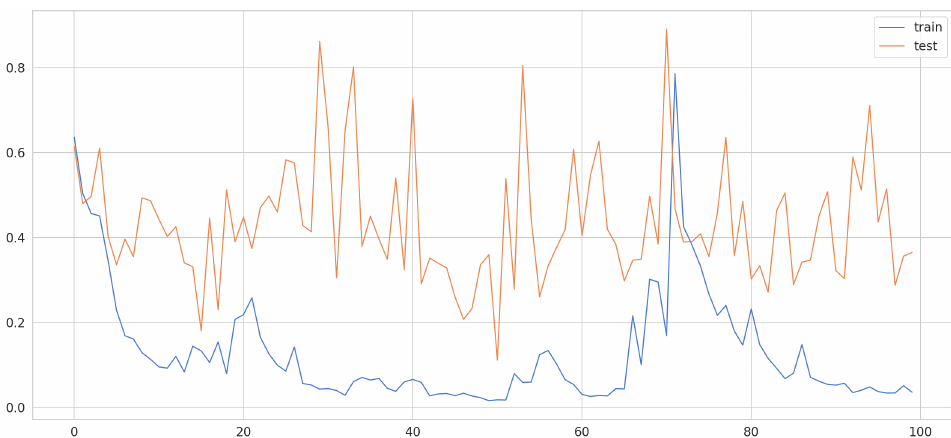
Figure 14. LSTM history loss training and testing